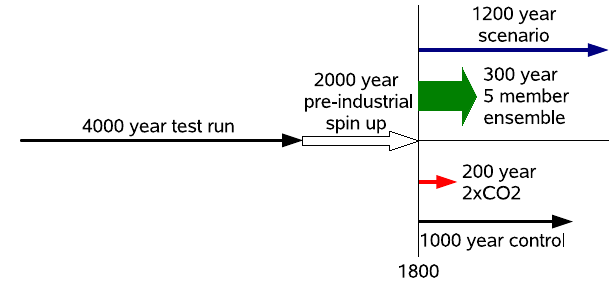
Fig. 1. Schematic overview of the SPEEDO